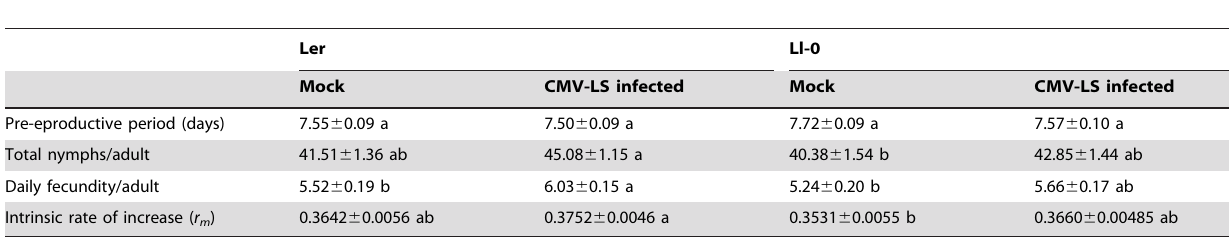
Table 4. Parameters of the life cycle of Myzus persicae grown on two different genotypes of Arabidopsis 1) .